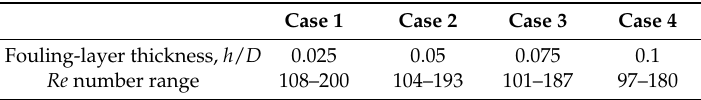
Table 1. Conditions of performed simulations in this study. Spacer geometry: L / D = 8, β = 90 ◦ . Sc number range: 1–100.